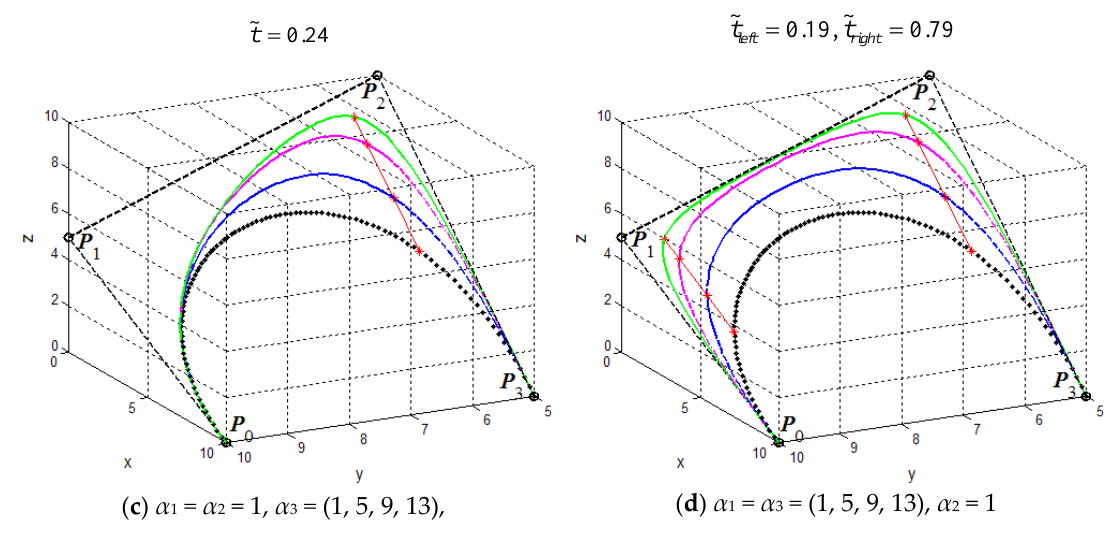
Figure 3. The influences of shape parameters on generalized cubic H-Bézier curves.